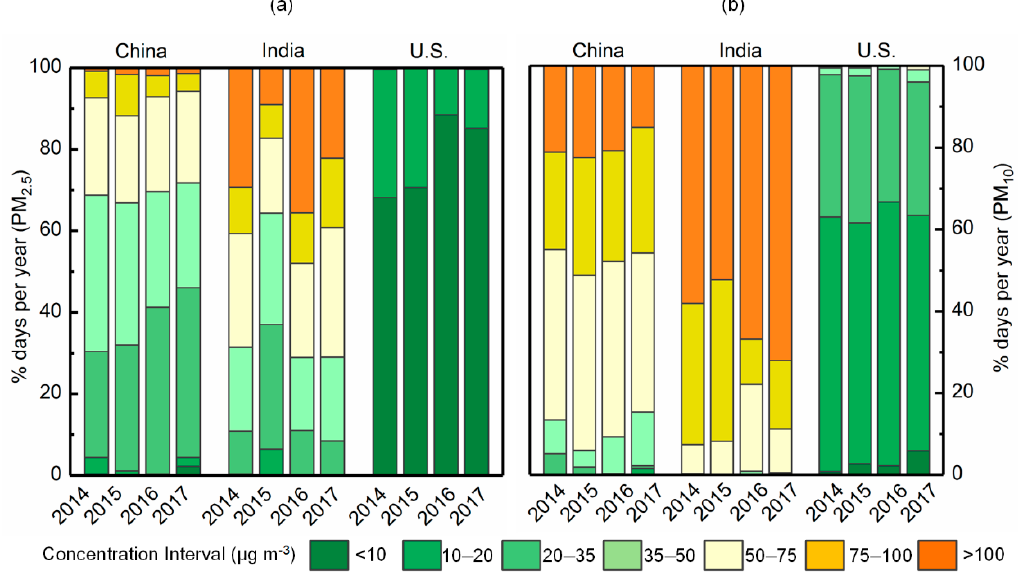
Figure 2. Annual range of daily particulate concentrations for China, India, and the U.S. for ( a ) PM 2.5 and ( b ) PM 10 .